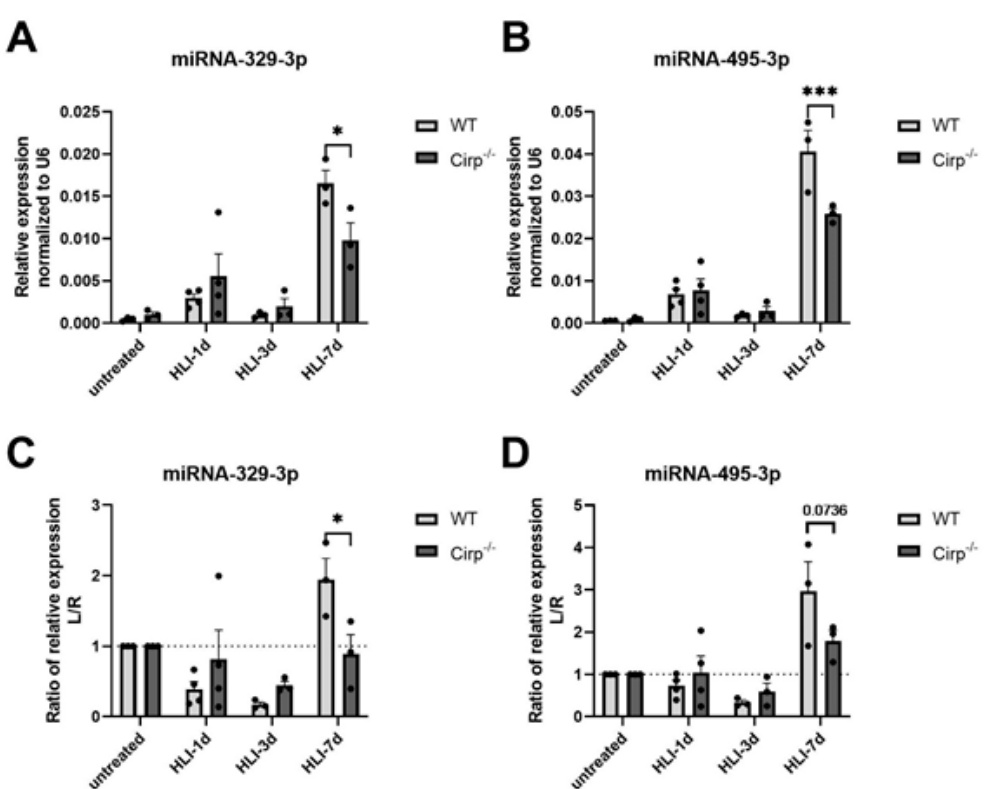
Figure 3. Expression of miRNA-329 and miRNA-495 in soleus muscles. ( A , B ) 1, 3, and 7 days after HLI surgery, mature miR-329-3p and -495-3p expression in soleus muscles of the ligated paws from WT mice ( n = 3 for the untreated group, n = 4 for the HLI-1d group, n = 3 for the HLI-3d group, and n = 3 for the HLI-7d group) and Cirp − / − mice ( n = 3 for the untreated group, n = 4 for the HLI-1d group, n = 3 for the HLI-3d group, and n = 3 for the HLI-7d group). Expression was normalized to U6 . ( C , D ) The relative expression of mature miRNA-329 and -495 from mice after HLI surgery at different timepoints, calculated as the ratio of the left (ischemic) over the right (non-ischemic) paw. Data are presented as the mean ± SEM; * p < 0.05; *** p < 0.001 by two-way ANOVA.